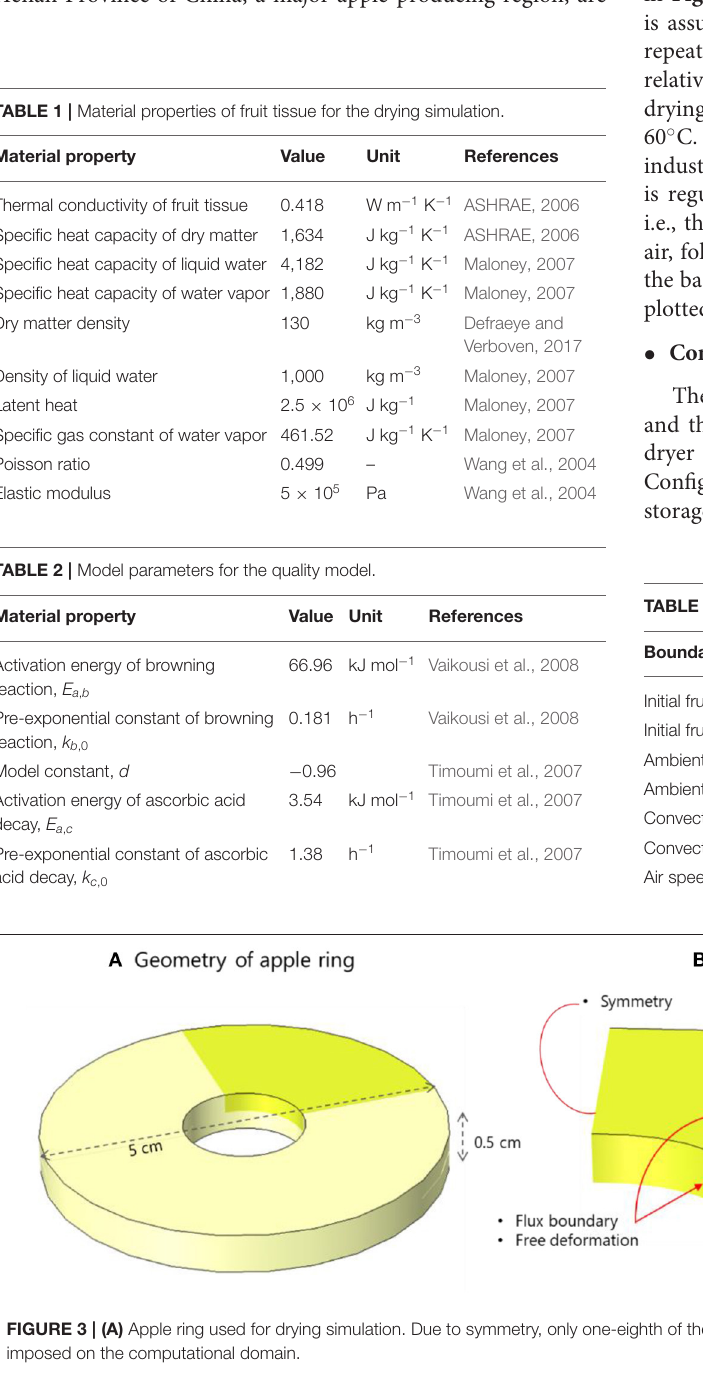
Frontiers in Sustainable Food Systems |